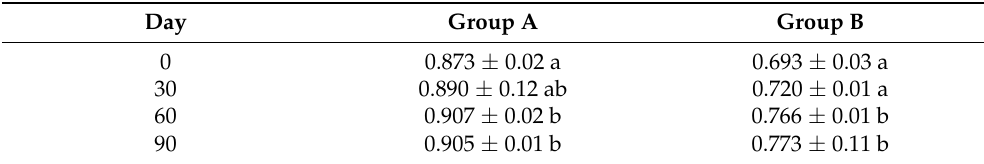
Table 1. The changes in amine nitrogen during the secondary fermentation of soy sauce and a lemon juice starter.